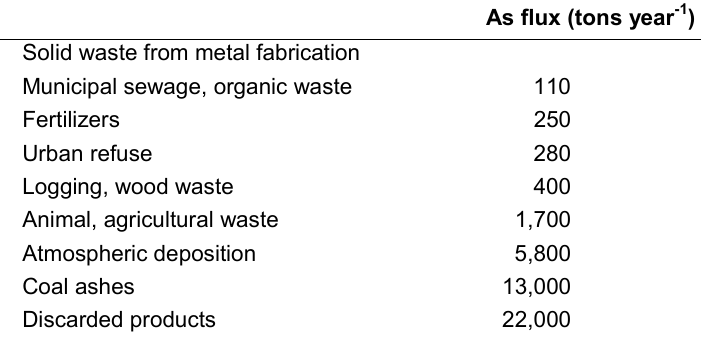
Global Atmospheric Arsenic Fluxes and Concentrations